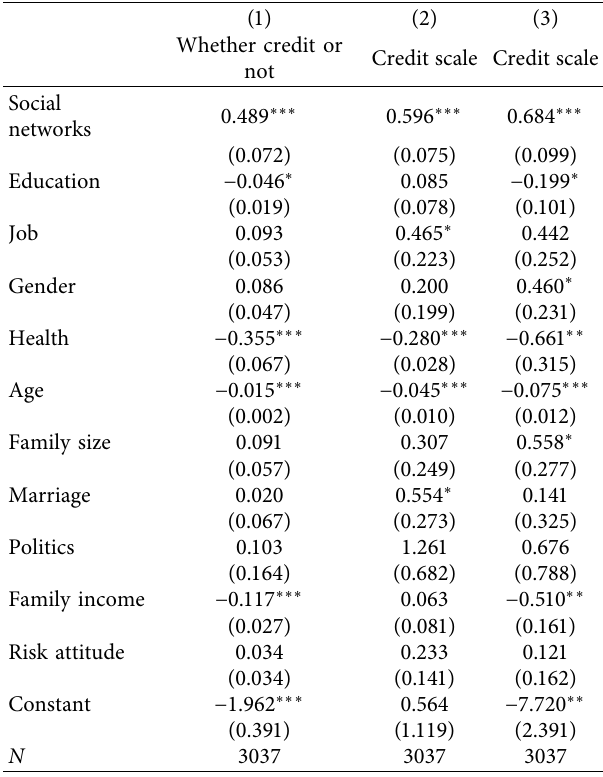
Table 3: Impact of social networks on rural household credit